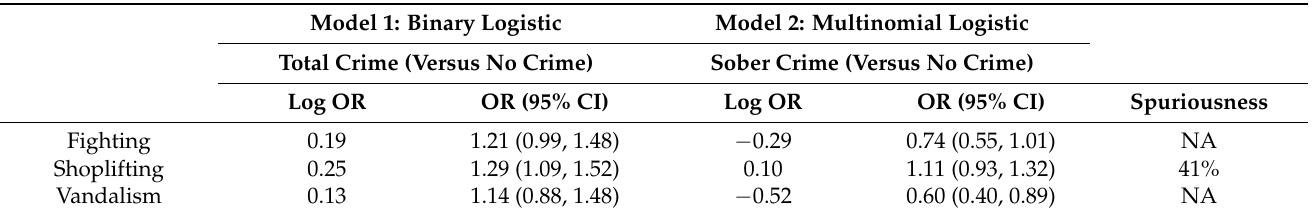
Table 4. Univariable associations between alcohol frequency (treated as a numeric variable) and total crime (model 1), and sober crime (model 2). Model 1: Binary Logistic Model 2: Multinomial Logistic Total Crime (Versus No Crime) Sober Crime (Versus No Crime)